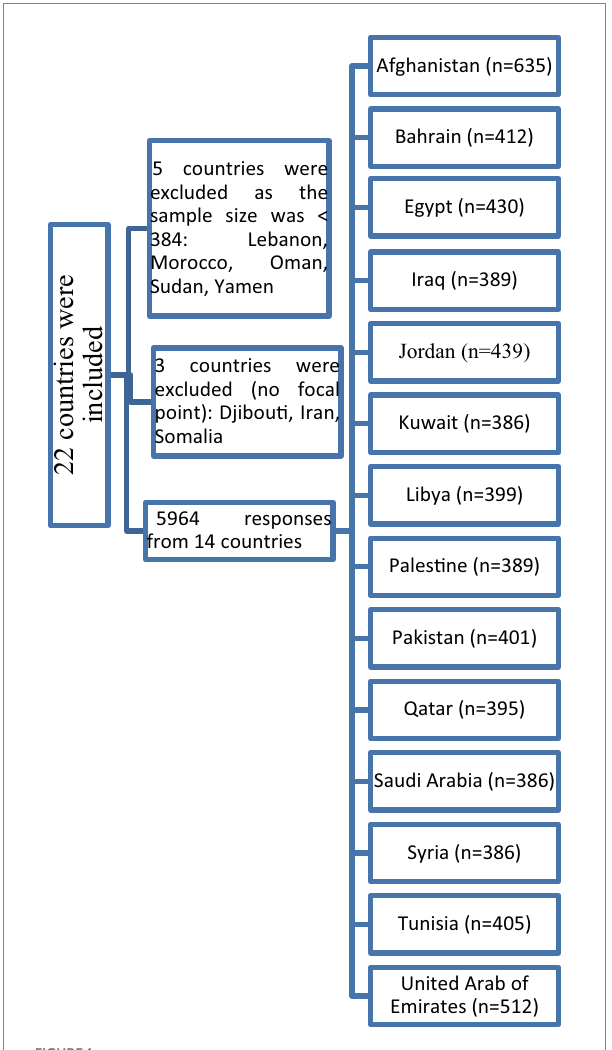
FIGURE 1 Flowchart of the study sample distribution across the Eastern Mediterranean